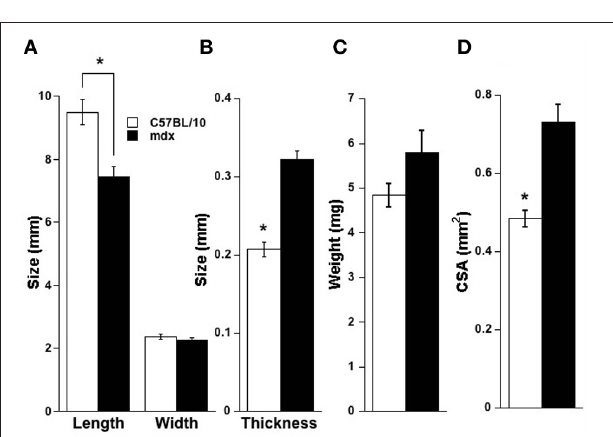
FIGURE 2 | Diaphragm strip parameters. (A) C57BL/10 strips were stretched to longer lengths ( p < 0 . 01), owing to lower elasticity in the mdx diaphragm (Stevens and Faulkner, 2000) compared to C57BL/10, and width did not vary ( p = 0 . 43). (B) The calculated thickness of strips was higher for mdx tissue vs. C57BL/10 ( p < 0 . 01). (C) Strip mass was not statistically different between C57BL/10 and mdx ( p = 0 . 07) but cross-sectional area based on mass of the strip (mass divided by the product of muscle density and length) was higher for mdx diaphragm strips vs. C57BL/10 ( p < 0 . 01), shown in panel (D) . ∗ indicates p < 0 . 05 between mdx and C57BL/10.